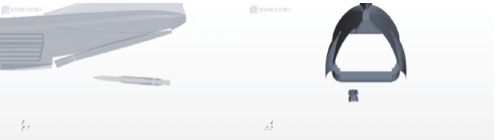
Figure 29: Missile movement posture at 0.8s.